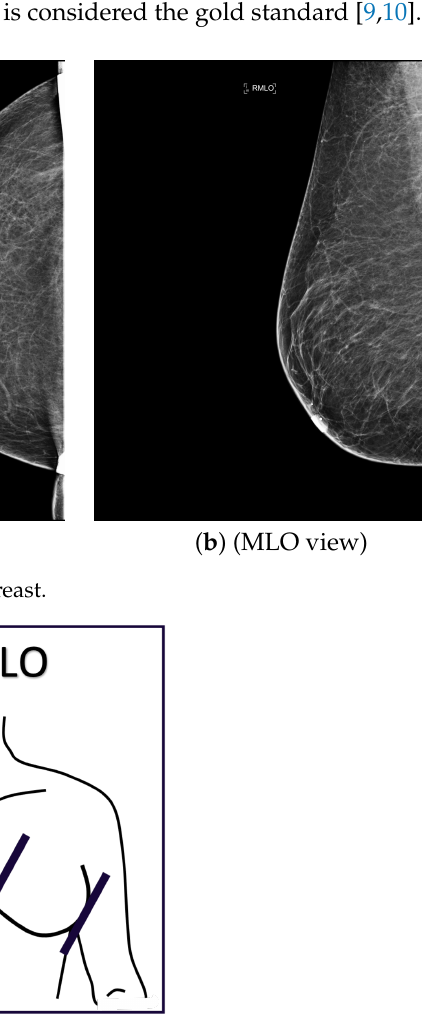
Figure 2. The difference between CC and MLO